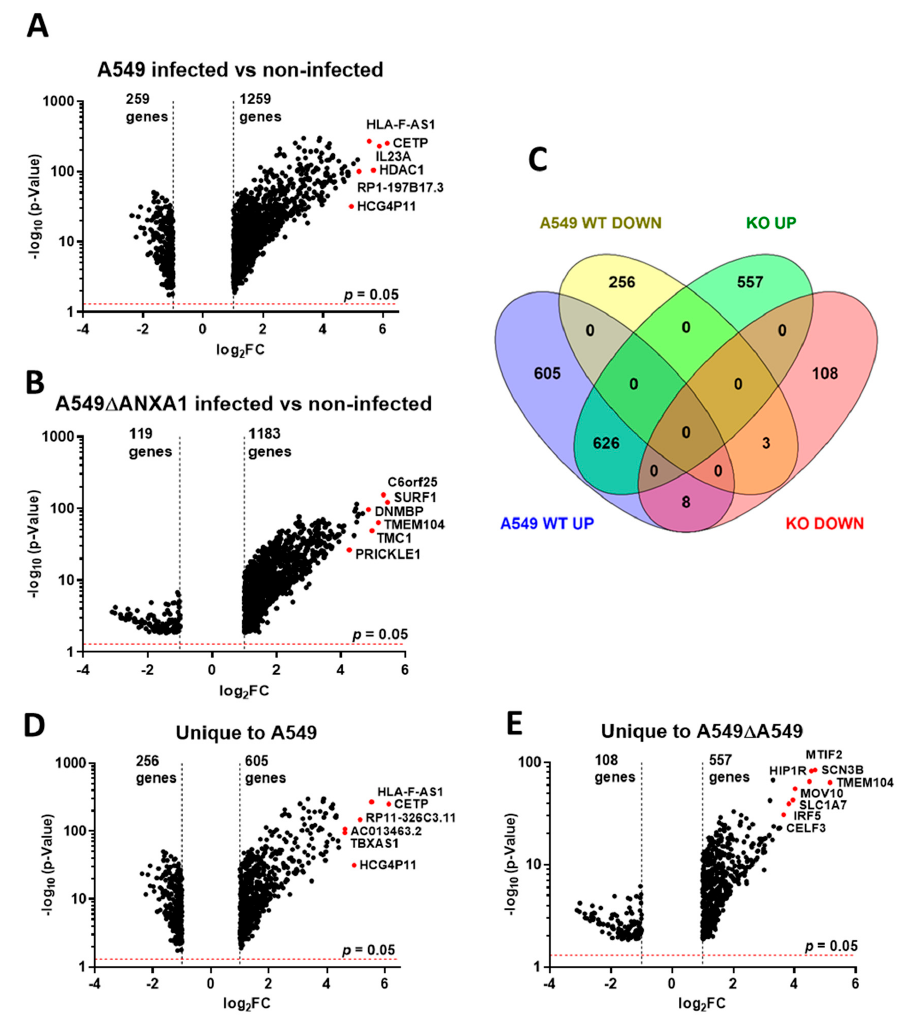
Figure 1. Global overview of the RNA-Sequencing data of influenza A virus (IAV)-infected lung epithelial (A549) cells with or without ANXA1 deficiency. ( A , B ) Volcano map showing the significant differentially expressed transcripts in A549 and A549- ∆ ANXA1. ( C ) The distribution abundance of differentially expressed genes/transcripts in upregulated and downregulated pattern in group A and B. MTBP (MDM2 Binding Protein), PMCH (Pro-Melanin Concentrating Hormone), FTO (alpha-ketoglutarate-dependent dioxygenase). ( D , E ) The unique expressed transcripts in group A and group B are plotted on a volcano map. The top genes selected showing the highest fold-changes are presented as red dots.